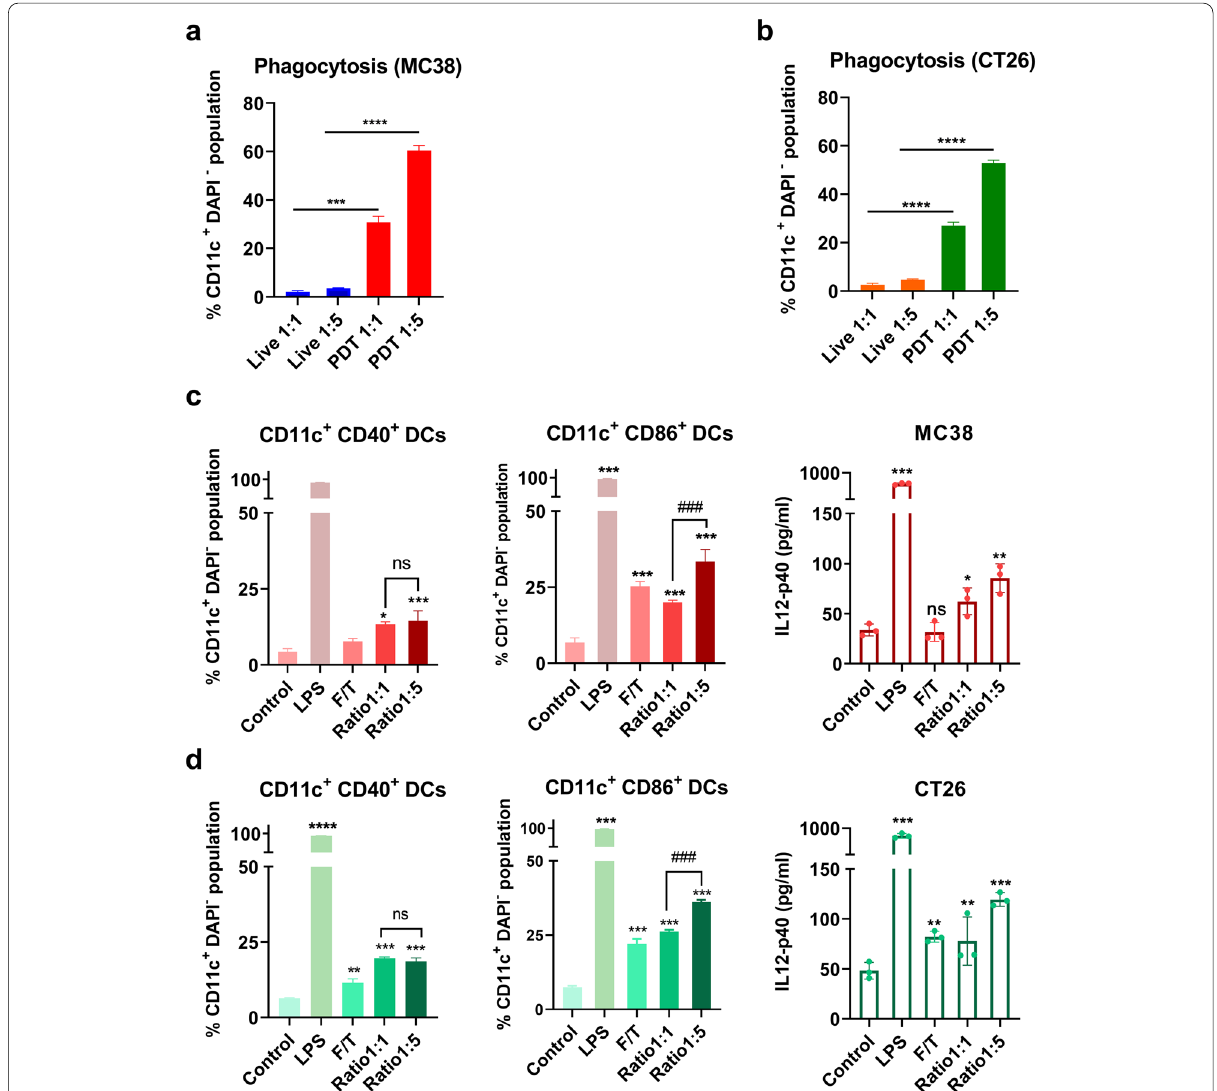
Fig. 4 Immune-stimulating effects of ICG-PDT-induced cell death in colon cancer cells on DCs. Phagocytosis assay of ( a ) MC38 cells and ( b ) CT26 cells either after treatment with ICG-PDT or untreated were co-incubated with DCs in vitro immediately post-treatment for 2 h in two different ratios (1:1 and 1:5). The percentage of CD11c + CMFDA + double-positive DCs that represent the phagocytosis DCs are shown as the mean values ( c ) The percentage of CD40 high and CD86 high cells in live DCs (CD11c + DAPI − cells) and IL12-p40 expression in co-culture supernatant after 18 h co-culturing with treated or untreated MC38 tumor cells were compared to the untreated DCs control group. ( d ) The percentage of CD40 high